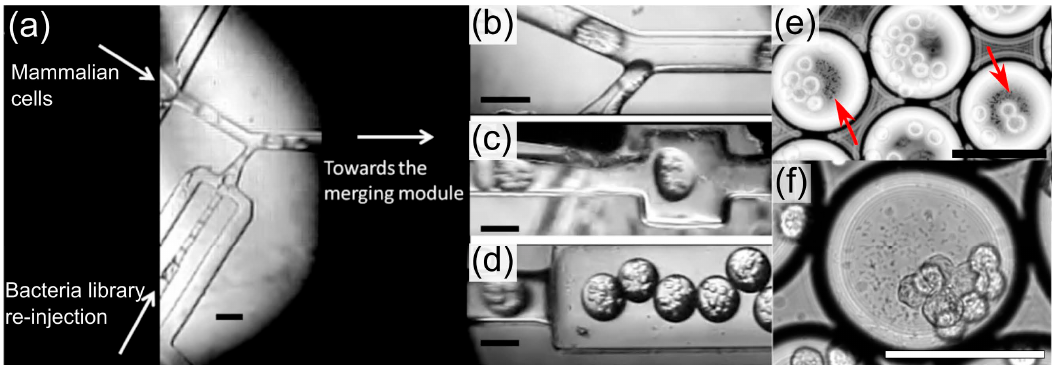
Figure 6. Droplet microfluidics for treatment of mammalian cells with metagenomic bacterial library. The device consists into a series of modules: ( a ) A nozzle to encapsulate mammalian cells and a nozzle to re-inject monoclonal droplets; ( b ) A fork to combine the droplet streams; ( c ) A merging module to perform pairwise electro-fusion of mammalian cells and monoclonal droplets and ( d ) a collection channel. ( e , f ) HeLa S3 cells co-encapsulated with bacteria (red arrows in e) at different magnification. Scale bars represent 100 μ m.